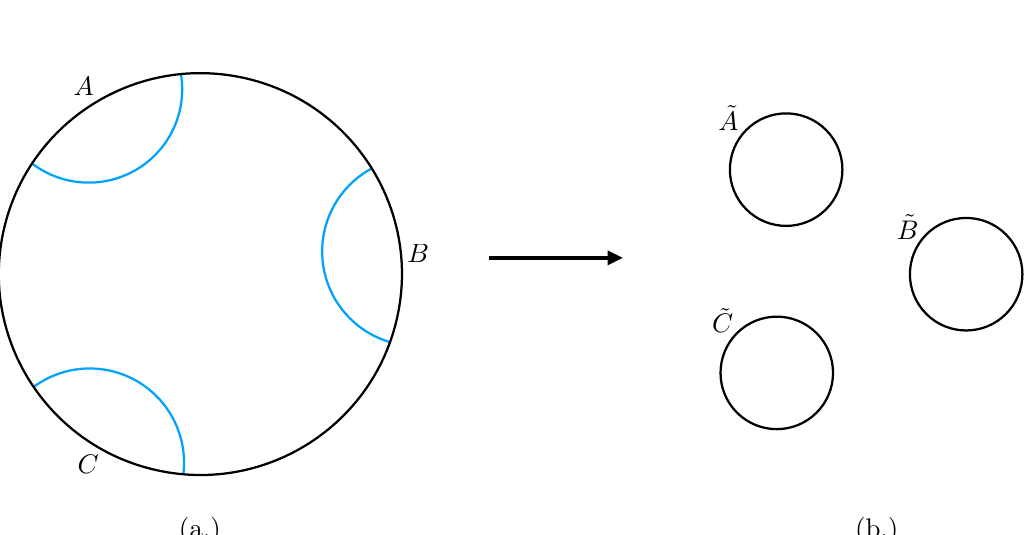
Figure 11 . The totally-disconnected phase, when the entanglement wedge of ABC is the disjoint union of the entanglement wedges of A , B , and C individually. Each boundary subregion is mapped to a disconnected trivial geometry.